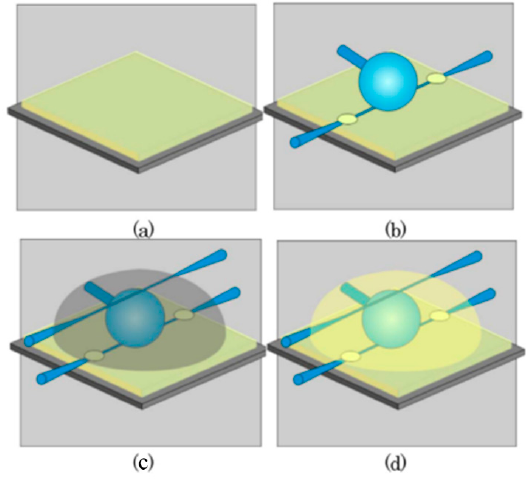
Figure 6. The fabrication and packaging process of the add-drop filter: ( a ) UV polymer was deposited on substrate; ( b ) the tapered fiber and silica microsphere were fixed; ( c ) the entire device were embedded in polymer; ( d ) cured with UV glue. [Reprinted/Adapted] with permission from ref [29], [OSA]. The relationship between the resulting resonant wavelength shift and temperature was obtained by changing the temperature outside of the entire coupling device, as shown in Figure 7. The wavelength shift is 604 pm when the room temperature was changed from 20 °C to 60 °C, while the resulting average temperature sensitivity was calculated as 15.2 pm/°C.